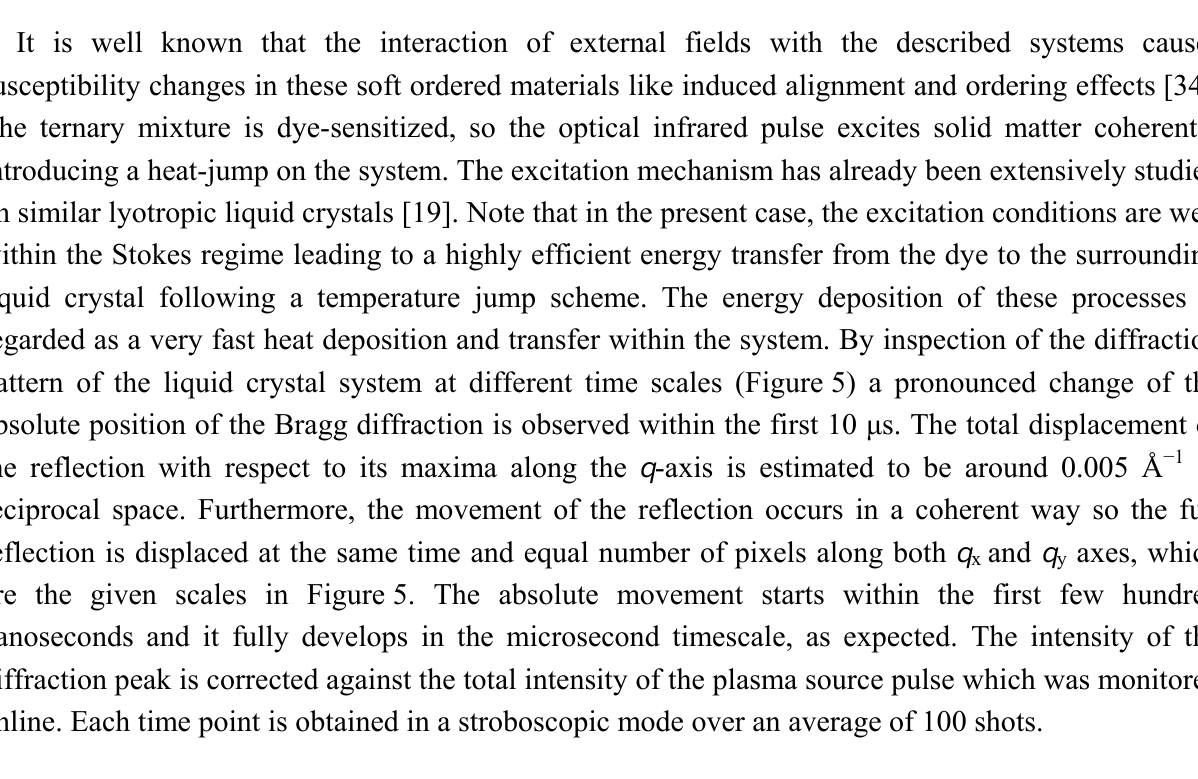
Figure 5. Time-resolved Bragg diffraction spot. The diffraction signal is displaced coherently in both q -axes, within the first 600